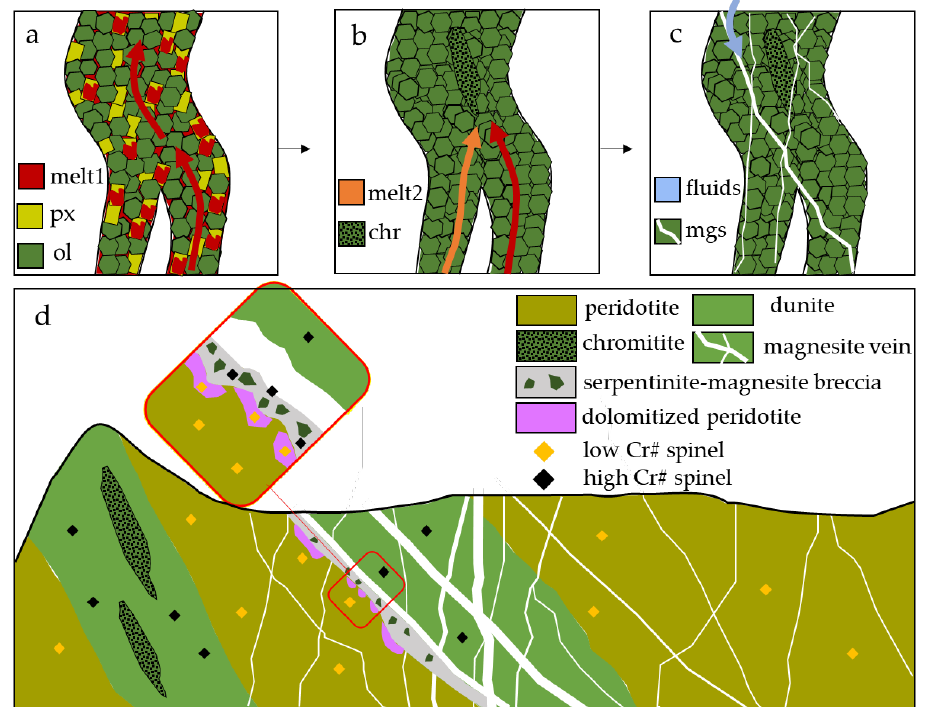
Figure 10. Schematic genetic model showing ( a ) infiltration of melts ascending through peridotite and inducing pyroxene melting, and the formation of a restitic dunite; ( b ) different melts can mix and induce precipitation of chromitite due to chromite oversaturation; ( c ) after the obduction of the oceanic crust, the weaker zones of the dunite channels can be reactivated as CO 2 -rich fluid pathways, precipitating magnesite in stockwork veins; ( d ) out-of-scale scheme of Kymasi chromitites and magnesite main veins, showing the difference in spinel mineral chemistry.